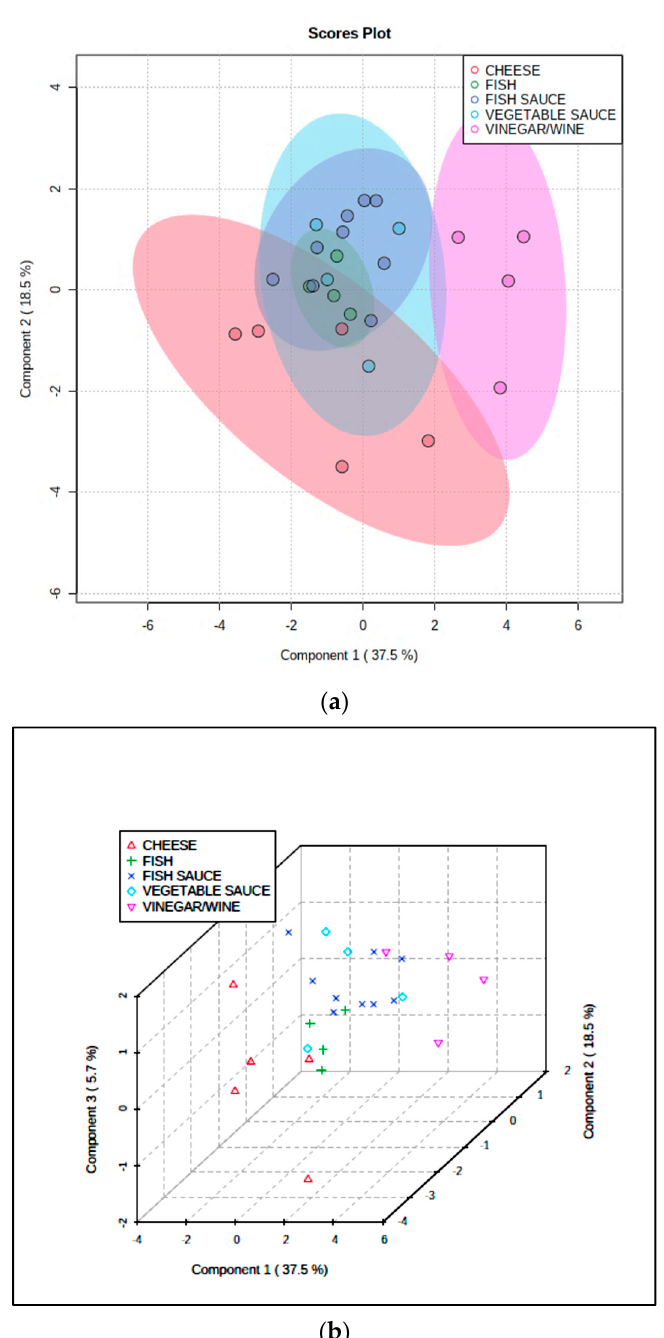
Figure 4. ( a , b ). 2D and 3D PLS-DA scores plots (PC2 vs. PC1, and PC3 vs. PC2 vs. PC1, respectively) revealing strong distinctions between the cheese, wine / vinegar, and a considered combination of fish, fish sauce / paste and vegetable sauce fermented food groups (( a ) also shows 95% confidence ellipses for each fermented food classification). Little or no distinction between the latter three fermented food groups were discernable using this MV analysis